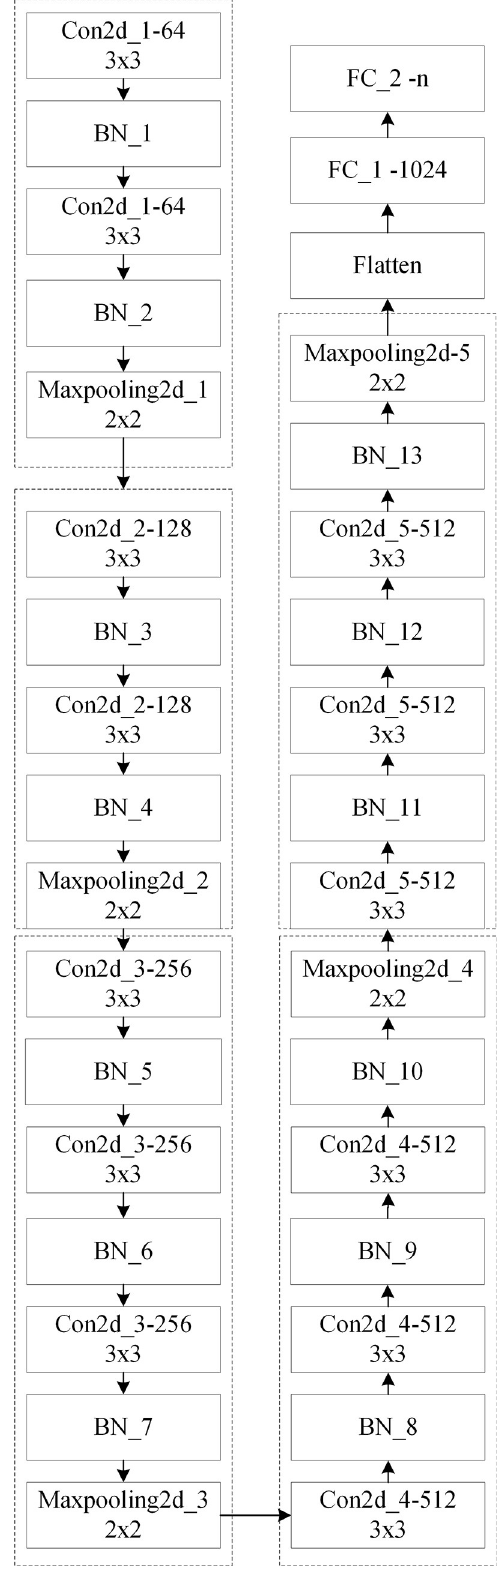
Fig 1. CNN architecture used in this